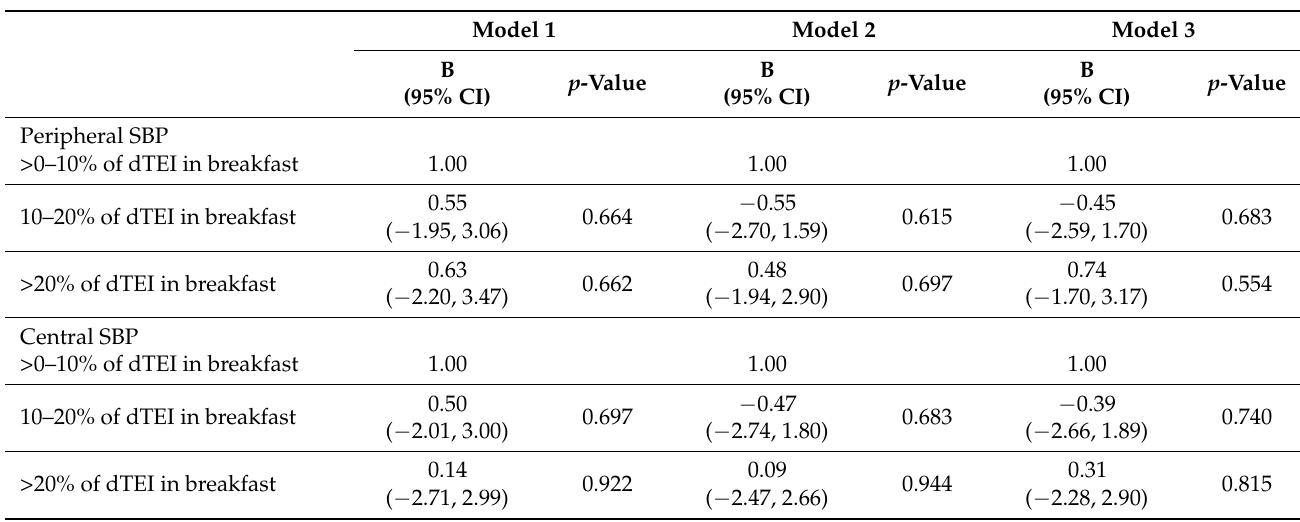
Table 5. Associations between subclinical vascular biomarkers and systematic breakfast consumption categories according to percentage of dTEI consumed at breakfast, using a reference the >0–10% of dTEI